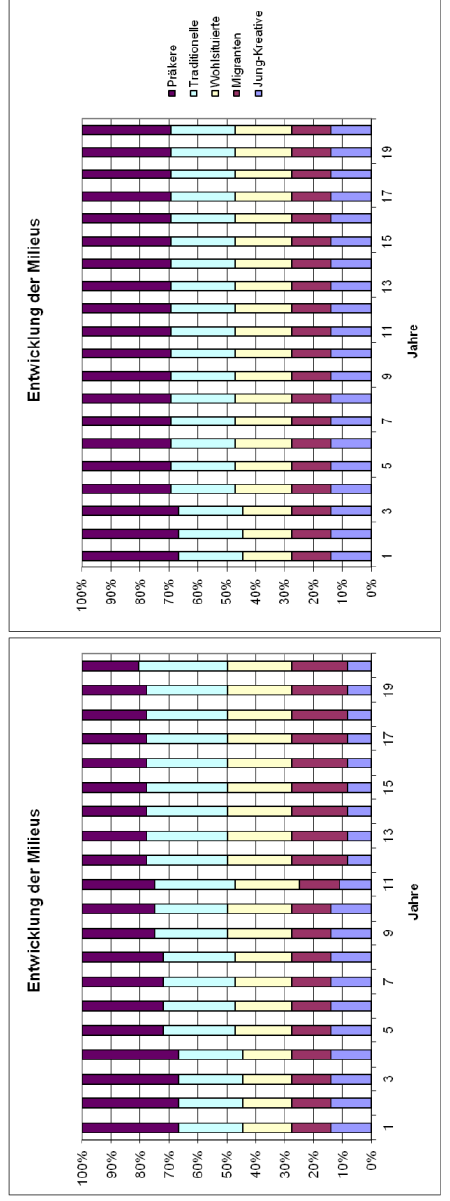
Figure 2. left / bottom: change in milieus by full allocation of insulation costs onto rental fee; right / top: slight change in milieus by having full